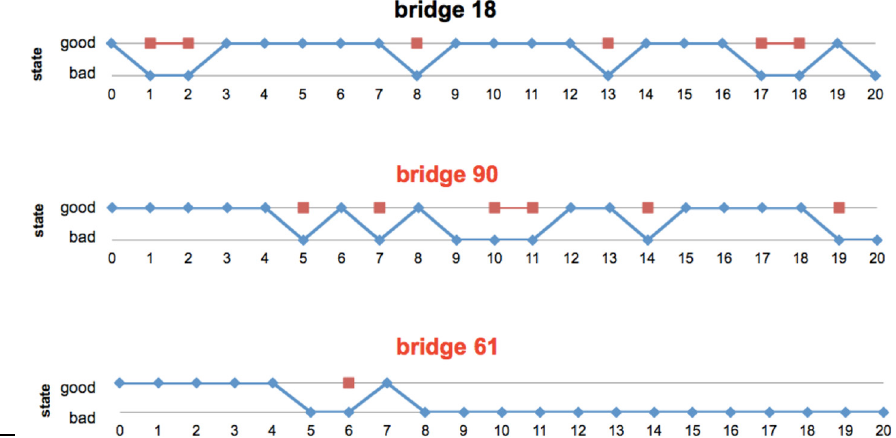
Figure 2. Condition state and repair decision for sample bridges in Category